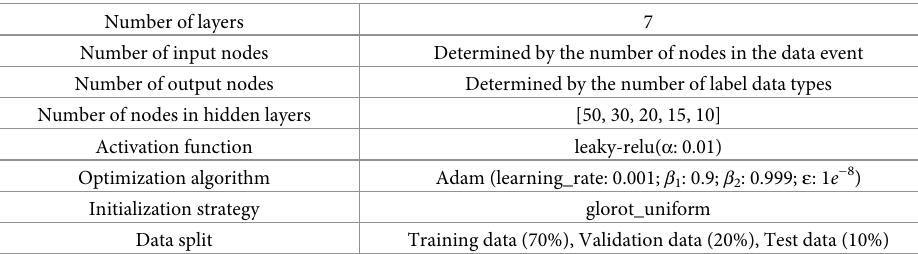
Table 1. Neural network parameter